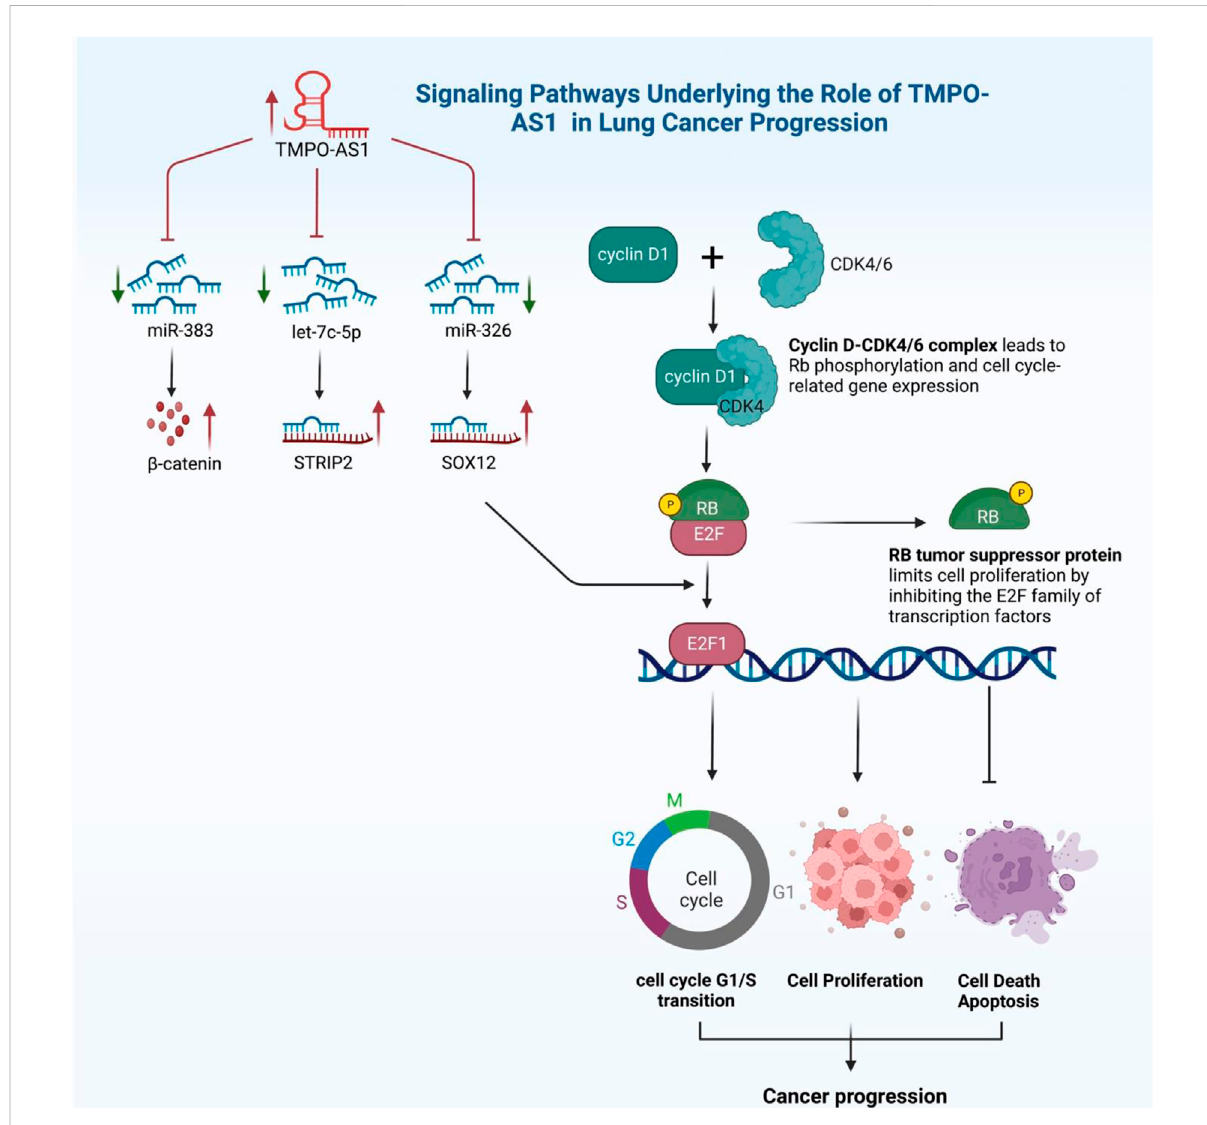
FIGURE 2 Signaling Pathways underlying the role of TMPO-AS1 in Lung Cancer